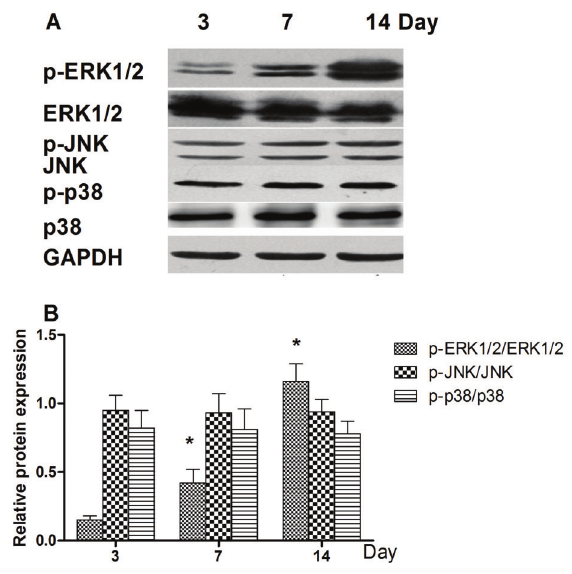
Figure 3 . Effects of BMP-2/PELA/VEGF scaffolds on the activa- tion of mitogen-activated protein kinase (MAPK) signaling in rats mesenchymal stem cells. A , Expression of total and phosphory- lated ERK1/2, JNKs, and p38 proteins. B , Contrast gray values corresponding to phosphorylated ERK1/2, JNKs, and p38 based on western blotting analysis. Results are reported as means ± SD (n=5). *P o 0.05, compared to the 3-day group (ANOVA). BMP-2: bone morphogenetic protein-2; PELA: polylactide-poly (ethylene glycol)-polylactide; VEGF: vascular endothelial growth